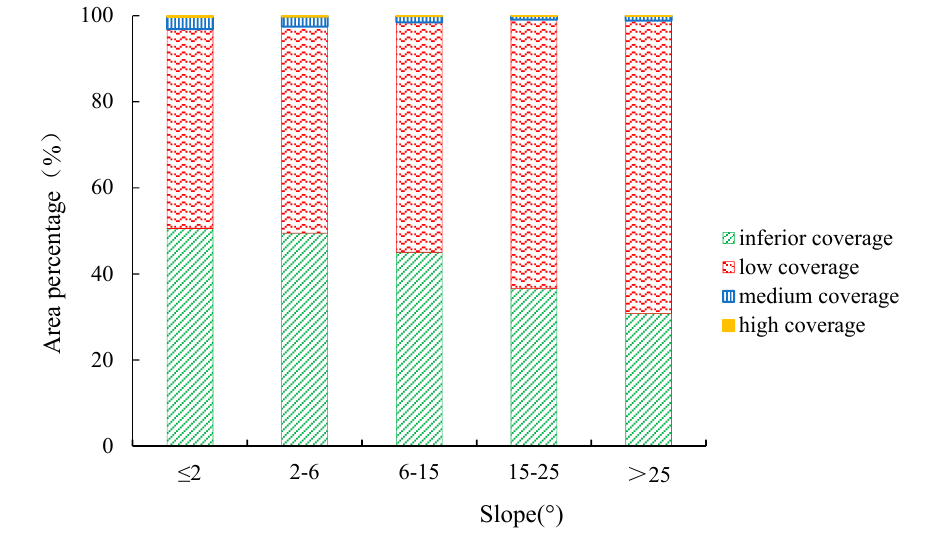
Figure 10. Area percentage of vegetation coverage in different slopes.